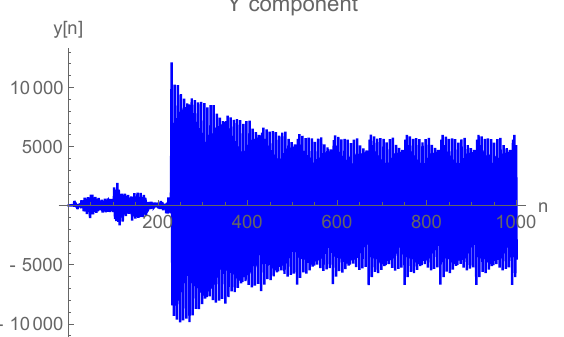
Figure 9. Graph of y n for α = 2.5, β = 0.05, γ = 0.7, δ = 0.6, ζ = 3.5, η = 0.05, µ = 0.01, ε = 4.1, υ = 0.09, ρ = 0.02, σ = 0.04, ω = 0.06. with initial conditions x 0 = 0.1, y 0 = 0.02 and z 0 =